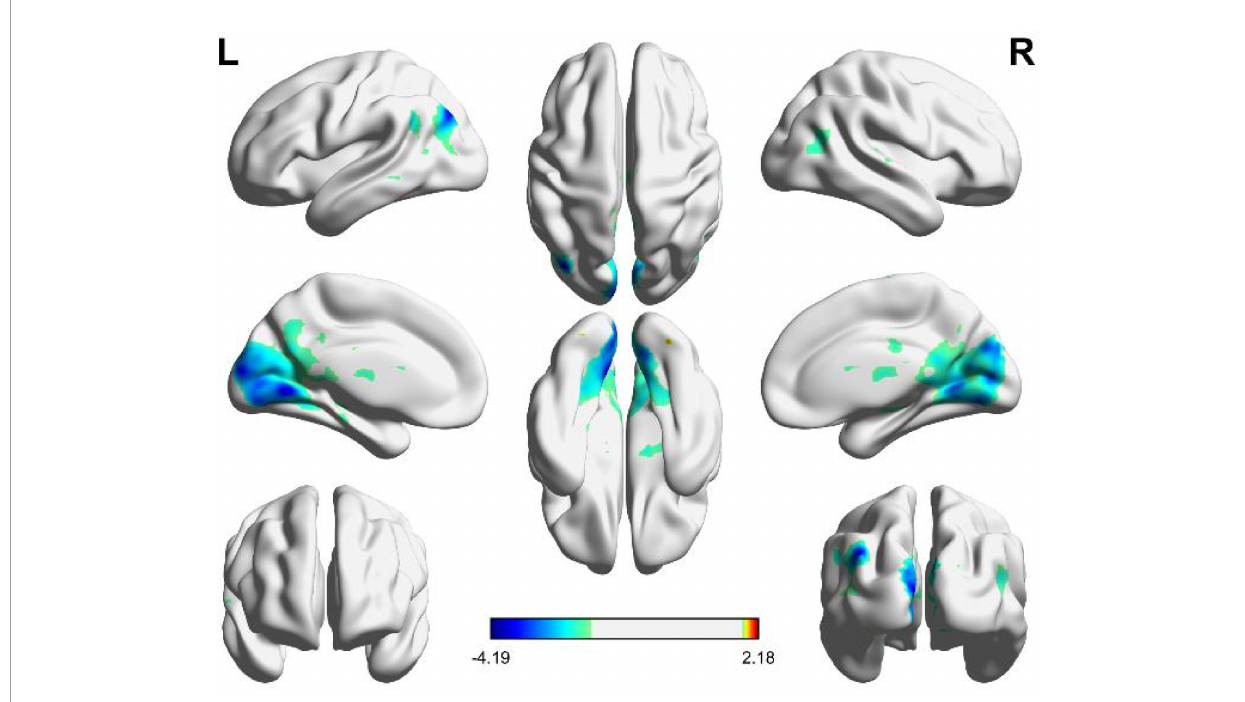
FIGURE4 Brain functional areas activated by angular shapes. The color bar indicates the size of the activation intensity. The values indicate positive or negative activation.